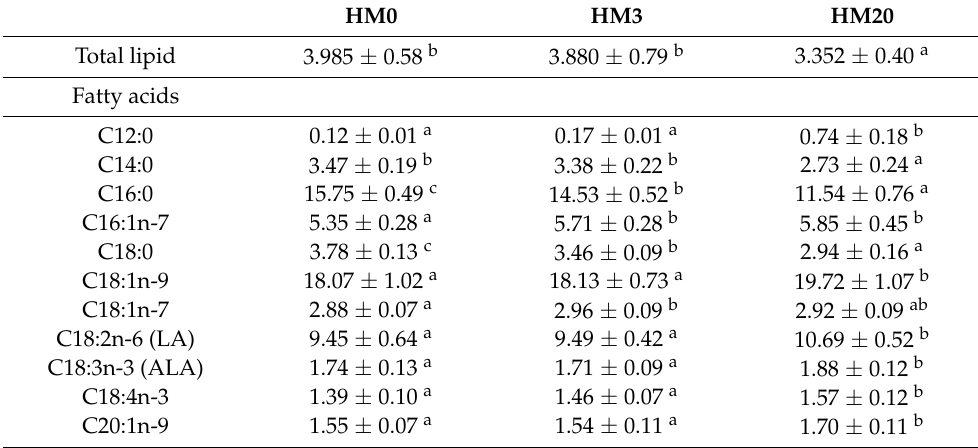
Table 7. Total lipid (g/100 g) and FA composition of fillets from rainbow trout fed the three exper- imental diets, expressed as % of total FA. Results are presented as mean ± SD ( n = 15). Different letters within the same row mean statistical difference ( p <